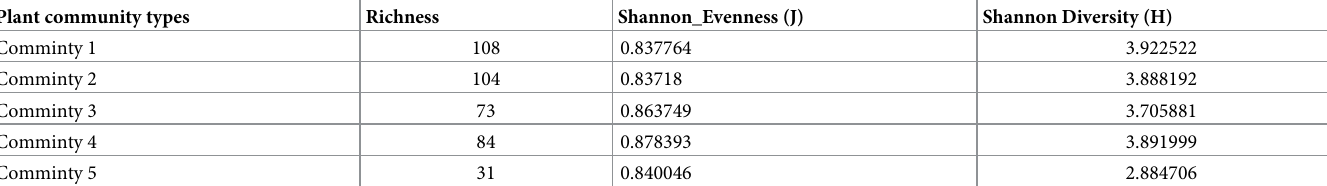
Table 4. Diversity and evenness of plant communities.